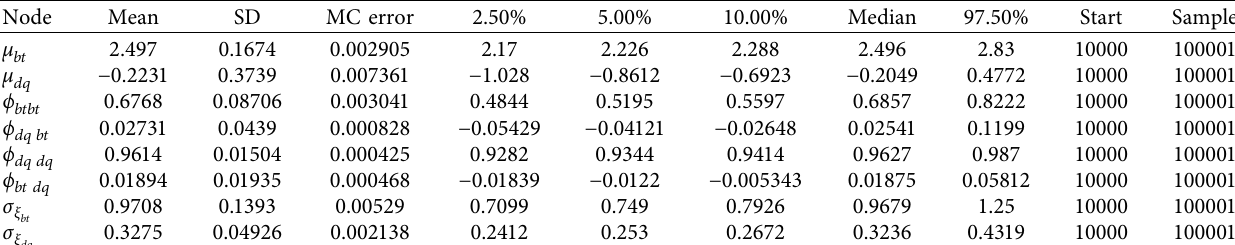
Table 2: The simulation results of posterior parameters of bitcoin and Dow